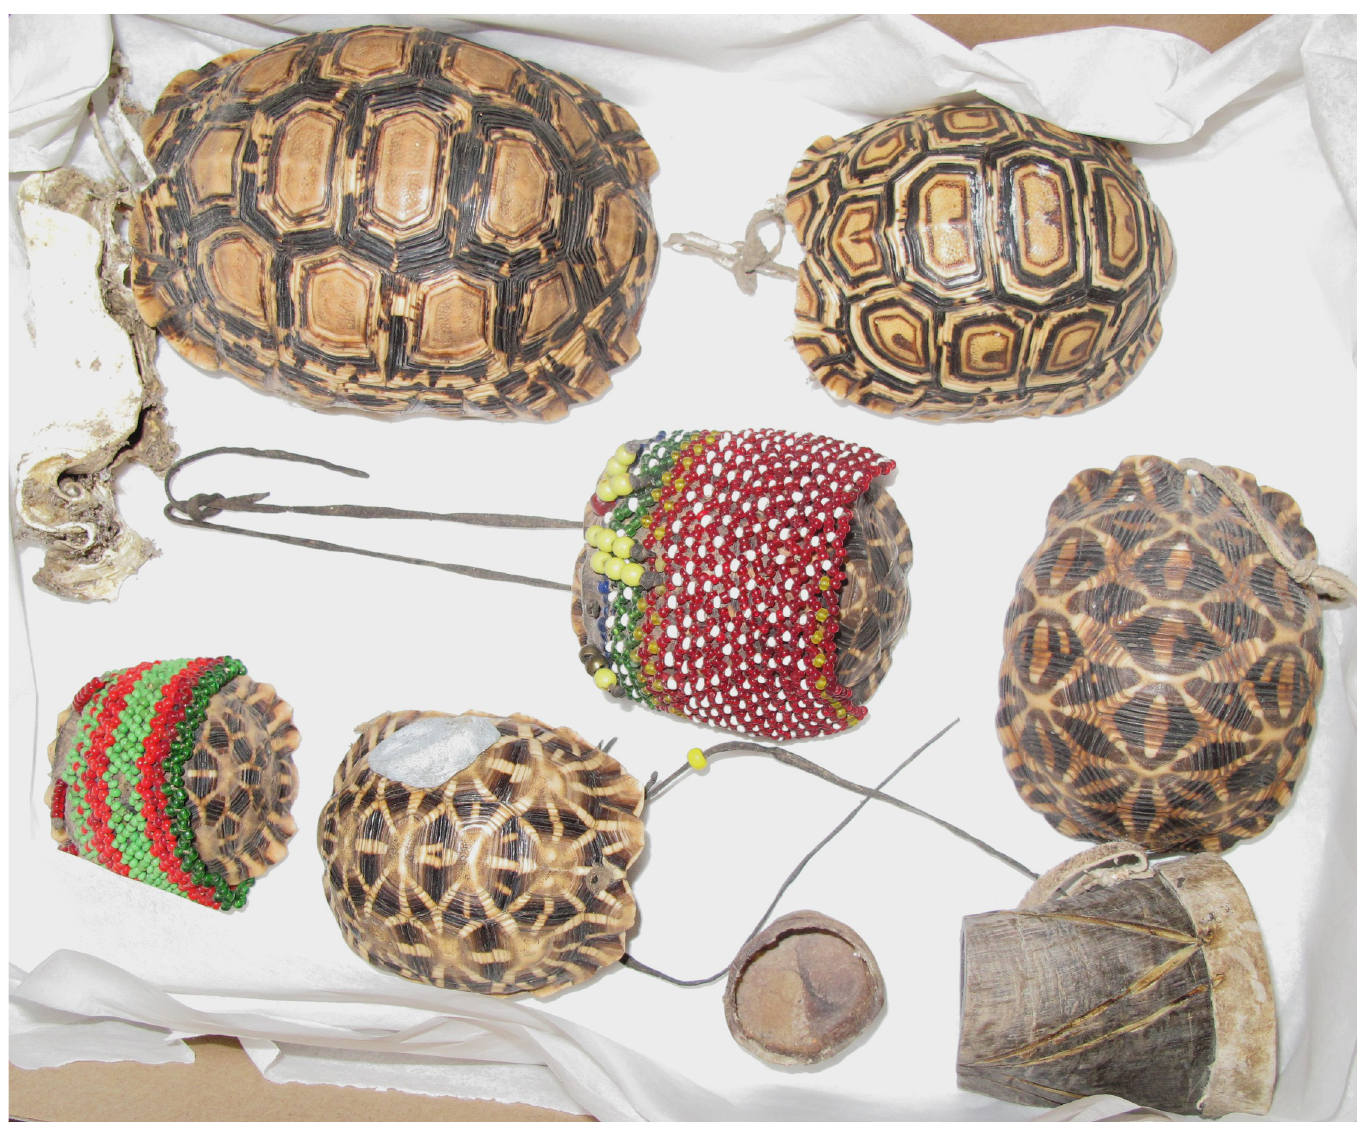
Fig 1. Examples of ethnographically recorded organic containers: Six containers made from tortoise shell and one from bone, Central Kalahari from Ghanzi farm Bushmen, Botswana 1973 (Unaccessioned, Russell and Russell Kalahari Collection, University of the Witwatersrand, South Africa) [42].